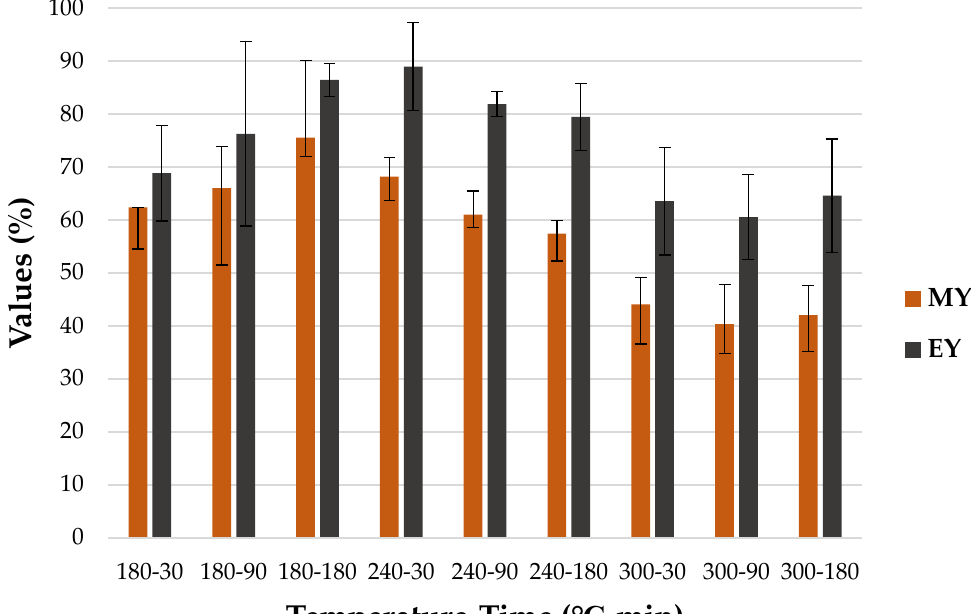
siderable HC yield change, which can be seen in Figure 5.